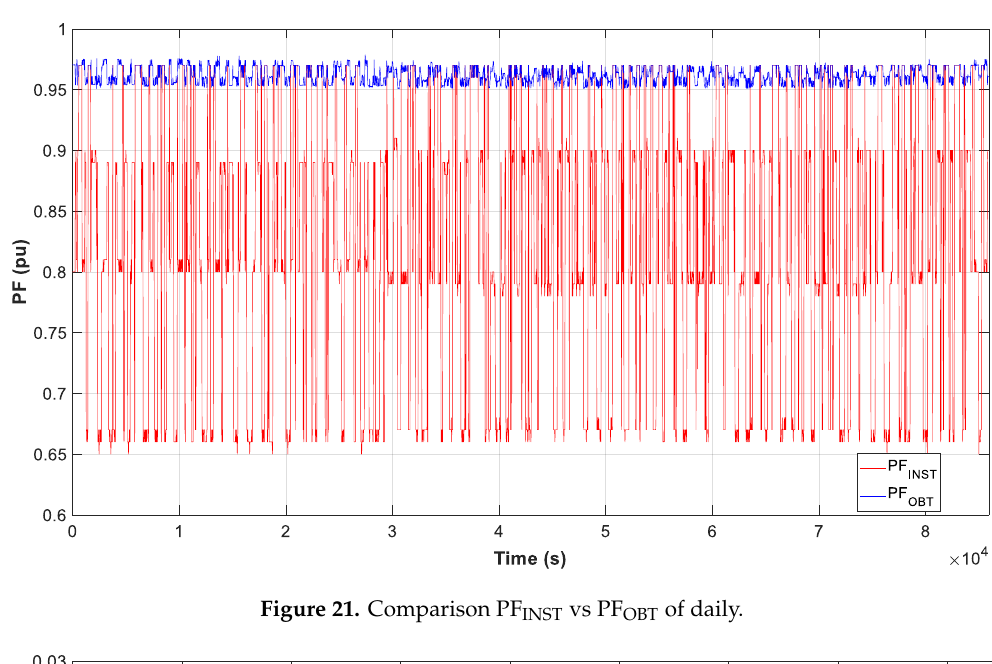
Figure 21. Comparison PF INST vs PF OBT of daily.